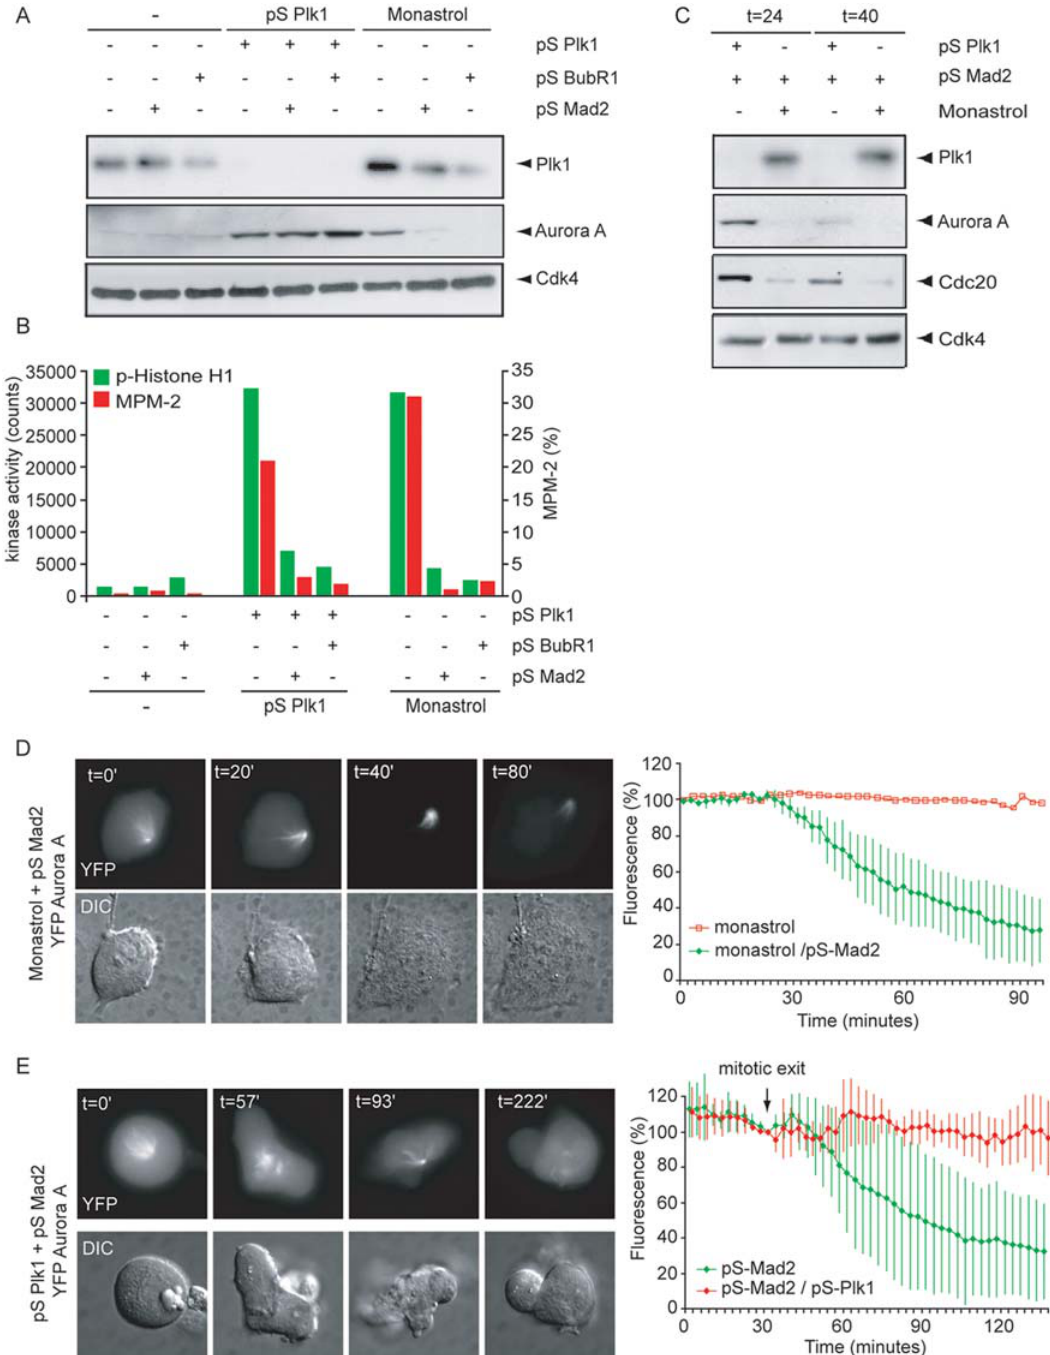
Figure 2. APC/C-Cdh1 activity in Plk1-depleted cells. A, B U2OS cells were transfected with 1 m g pBabePuro, 10 m g pS-Plk1, 10 m g pS-BubR1 or pS-Mad2 as indicated. 18 h after transfection, cells were incubated in thymidine and puromycin for 24 h. After washing away thymidine and puromycin, cells were treated with monastrol if indicated. Cells were harvested at 18 h after release from the thymidine block. Western blotting of whole cell lysates was performed with anti-Plk1, anti-Aurora A and anti-Cdk4. B Alternatively, cells were fixed in ethanol, stained with anti-MPM-2 and analyzed by FACS. MPM2-positivity of 1*10 4 events is plotted. In parallel, Cyclin B1-associated kinase was measured towards Histone H1. C U2OS cells were treated as for Figure 2A and harvested at 24 h or 40 h after release from a thymidine bock. Western blotting was performed with anti-Plk1, anti- Aurora A and Cdc20 and anti-Cdk4. D, E U2OS cells were transiently transfected with 1 m g Aurora A-YFP, 10 m g pS-Mad2 and 10 m g pS-Plk1 if indicated. 18 h after transfection, cells were incubated for 24 h in thymidine. Directly after washing away thymidine, monastrol was added to the culture medium if indicated. 10 h after washing away thymidine, cells were transferred to the heated stage of a time-lapse microscope. At indicated time points, DIC and fluorescent images were recorded. Fluorescence levels were quantified using Metamorph software (n=7 for each condition) and arbitrarily set at 100% at mitotic exit (t=0). Vertical lines indicate the standard error of the mean of 7 experiments.